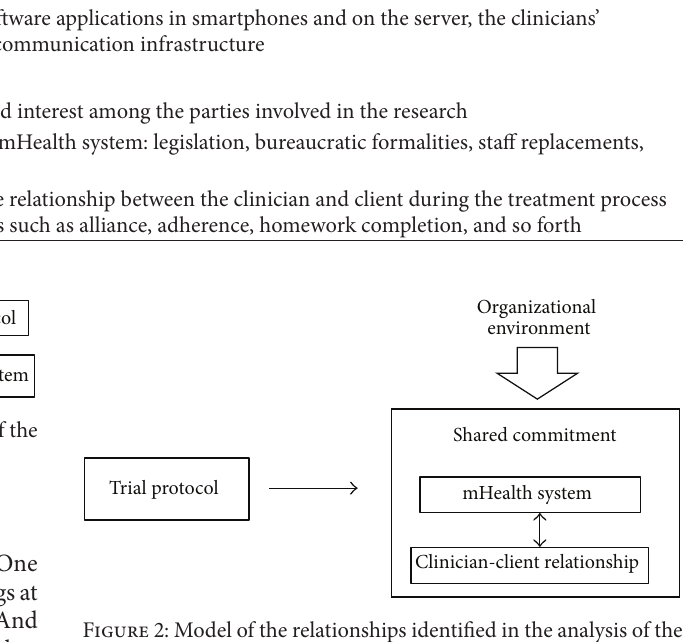
Figure 2: Model of the relationships identified in the analysis of the trial